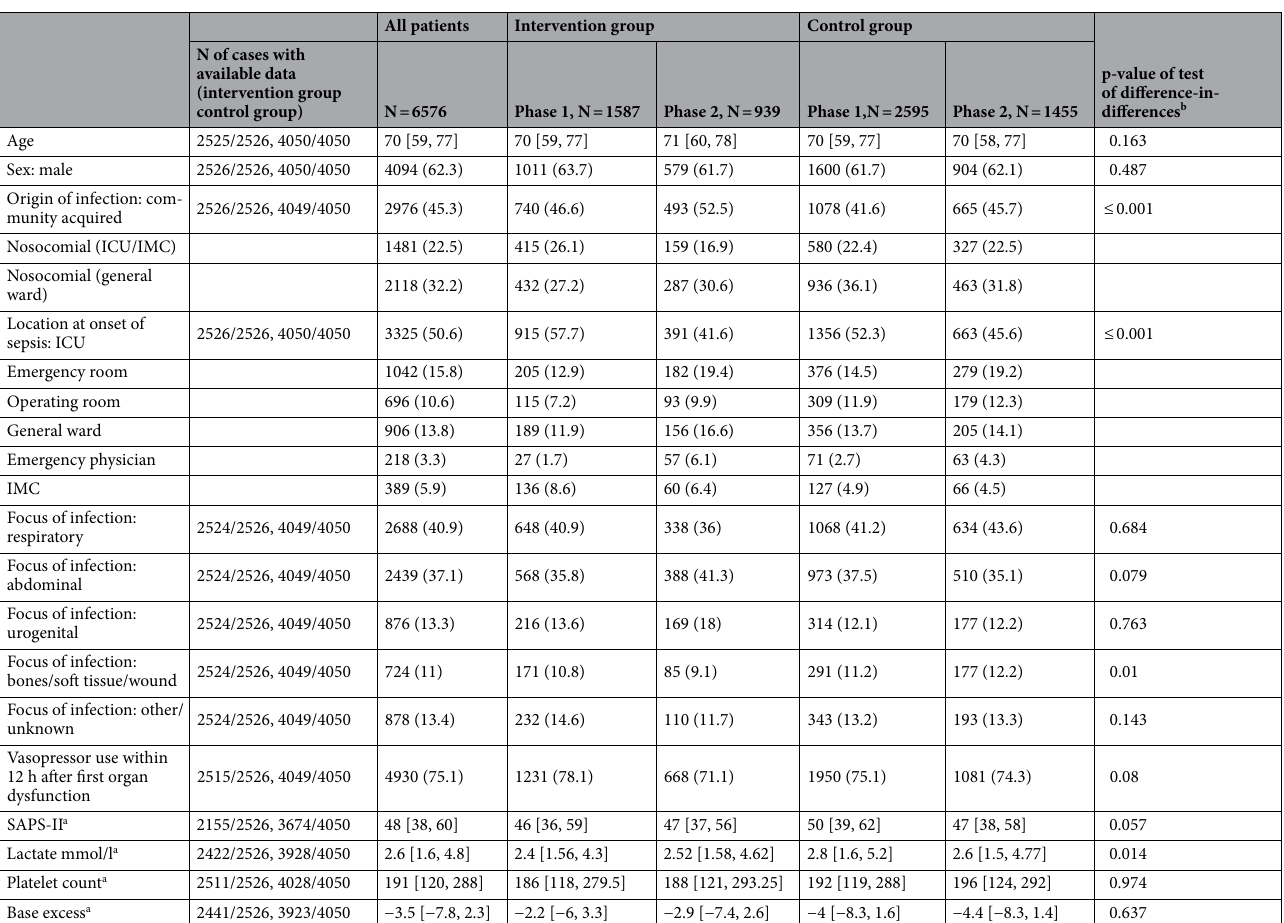
Table 1. Demographic and clinical characteristics of patients. Descriptive statistics given as median [1st quartile, 3rd quartile] or N (%). All 40 hospitals included in the analyses. Data on phase 1 have been previously published 16 . ICU intensive care unit, IMC intermediate care unit. a Assessed as maximum value during the first 24 h after first infection-related organ dysfunction. b Test of differences between groups regarding the change from phase 1 to phase 2. P-value obtained by testing the interaction effect between group and phase in a hierarchical generalized linear model with a random slope. For continuous variables a linear link-function was used, for dichotomous variables a logit-link was used, for categorical variables a multinomial model with a logit-link was